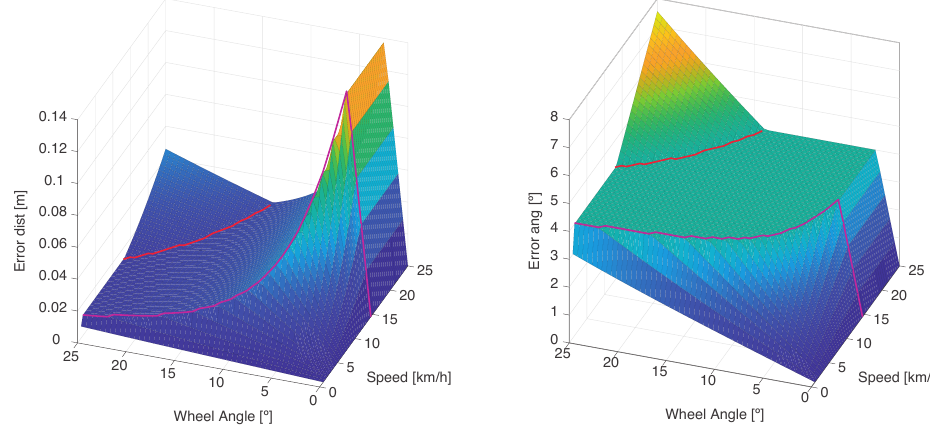
Figure 5. Time elapsed for a CPM event to trigger given different configurations.